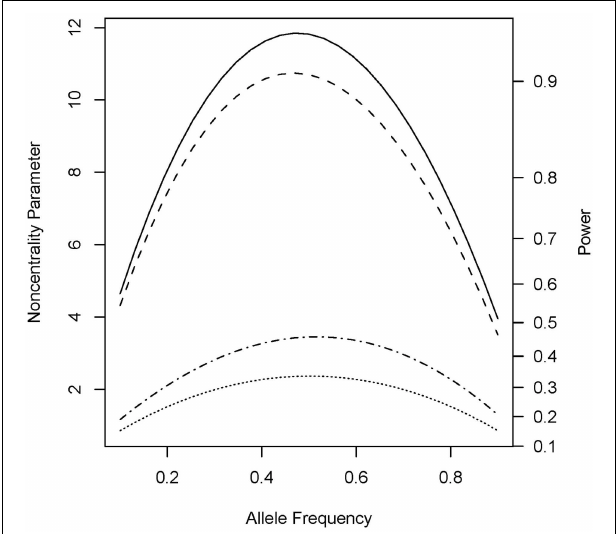
FIGURE 2 | Noncentrality parameter and power as a function of baseline risk in mothers of affected offspring. All designs used 300 complete triads in a homogenous population under the risk scenario: R 1 = R m 1 = 1 . 4 , R 2 = R m 2 = 1 . 96 , and S 1 = S 2 = 1 . The risk allele frequency is 0.3. Vertical axes: left, the chi-squared noncentrality parameter for a 1-df likelihood ratio test; right, power at α = 0 . 05 . Horizontal axis shows the baseline risk in mothers of affected offspring ranging from 0.05 to 0.45. Curves: dot, parenTDT ; dash-dot, Parent ; dash, combTDT ; solid, PPI-CT